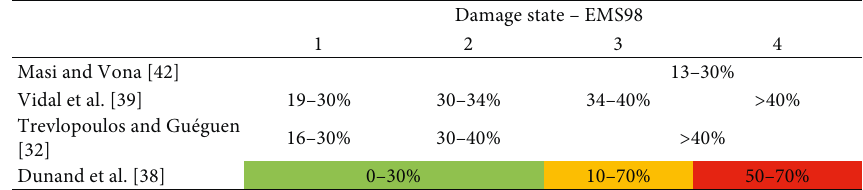
Figure 7: Summary of the EMS98 damage state classification according to the drop in the structural modal frequency, taken from the literature.